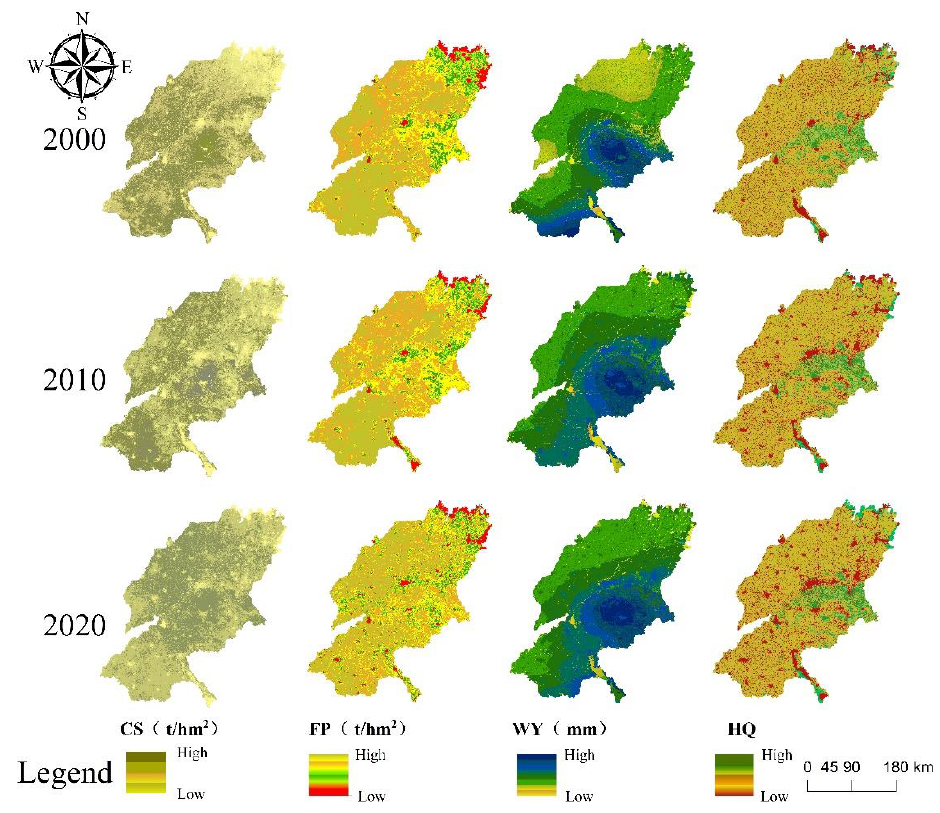
Figure 3. Spatial distribution of four different types of ES during 2000–2020.